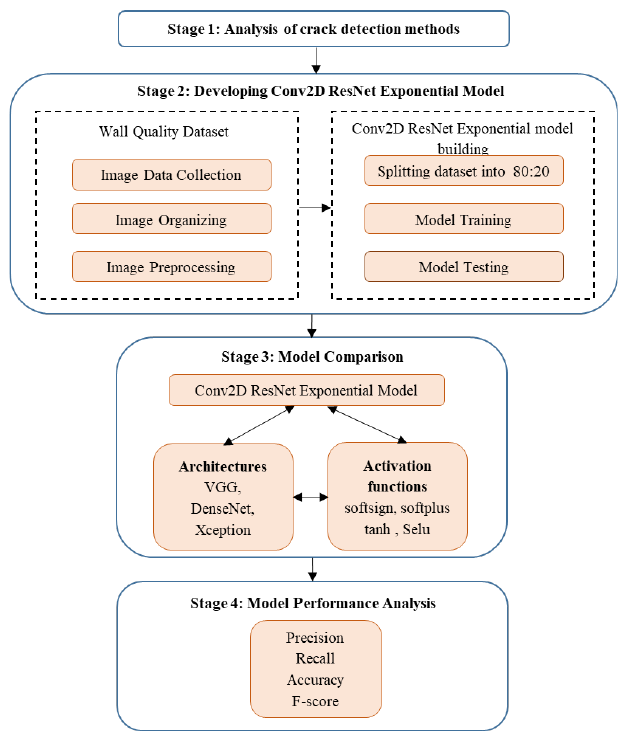
Figure 1. Research methodology flow.